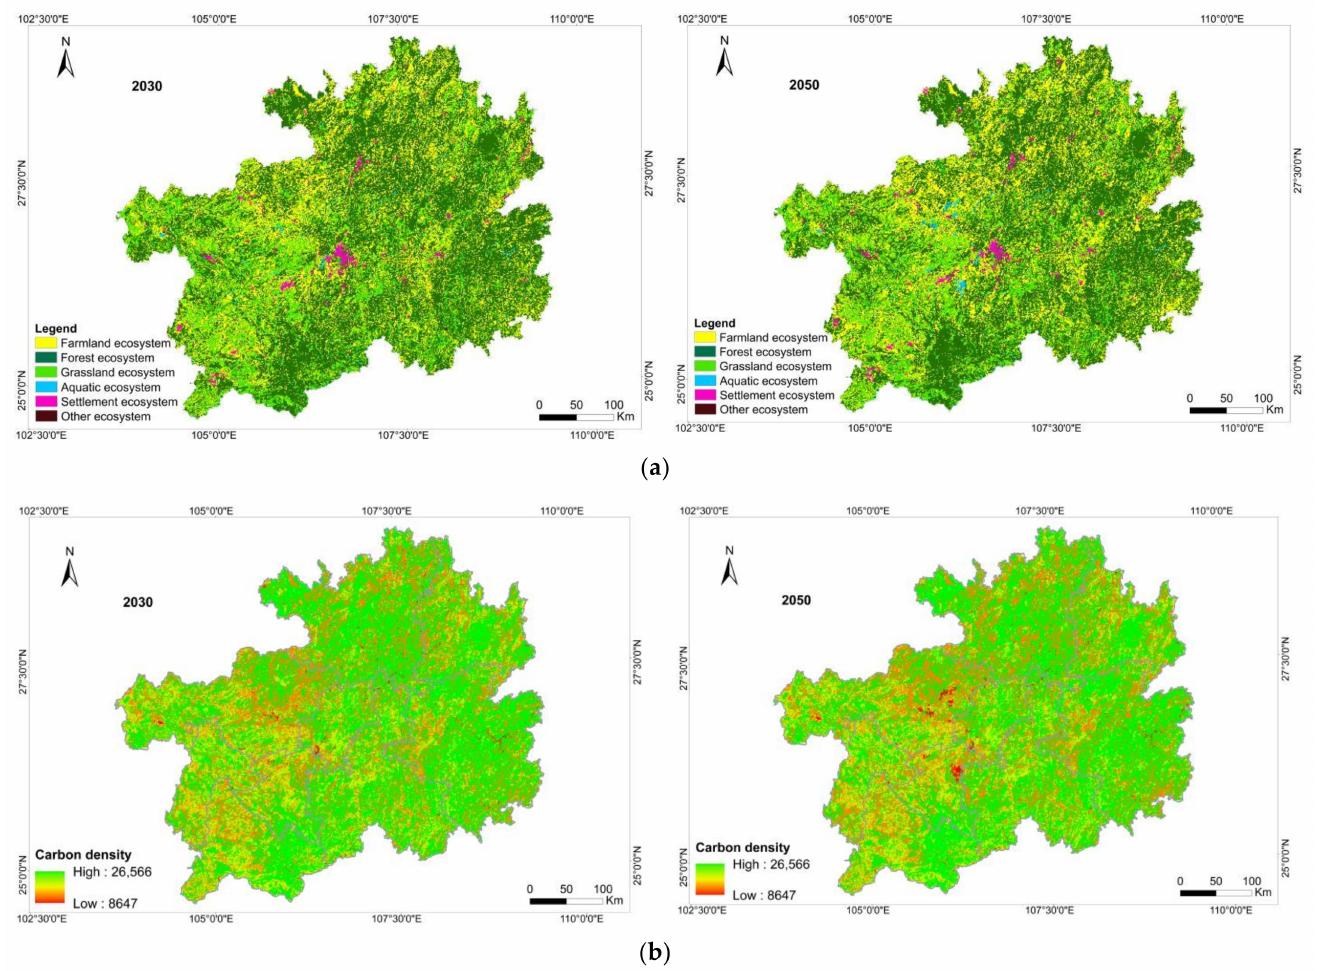
Figure 6. ( a ) Spatial distribution of the terrestrial ecosystem in 2030 and 2050; ( b ) spatial distribution of carbon storage in 2030 and